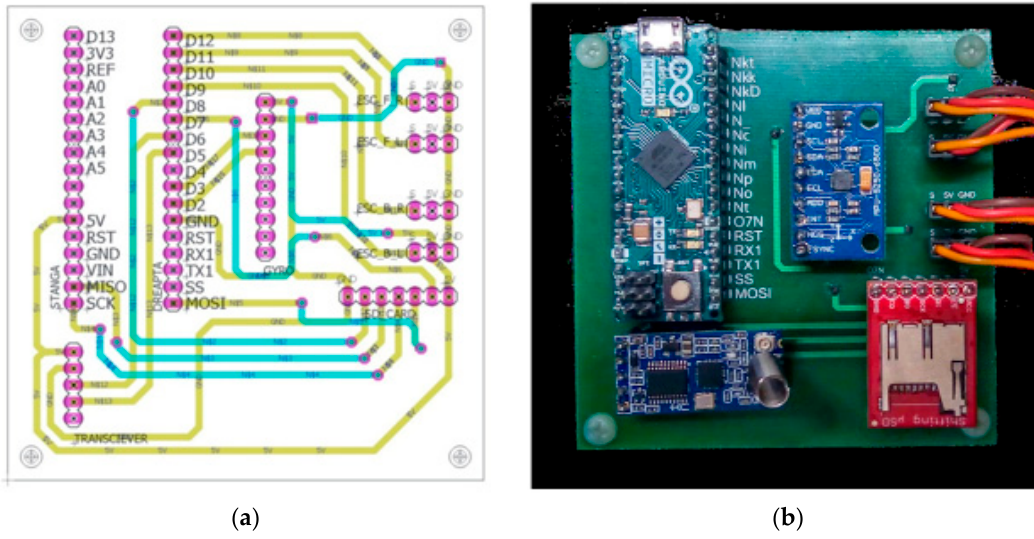
Figure 7. The designed ( a ) and implemented ( b ) electronic circuit of UAV.